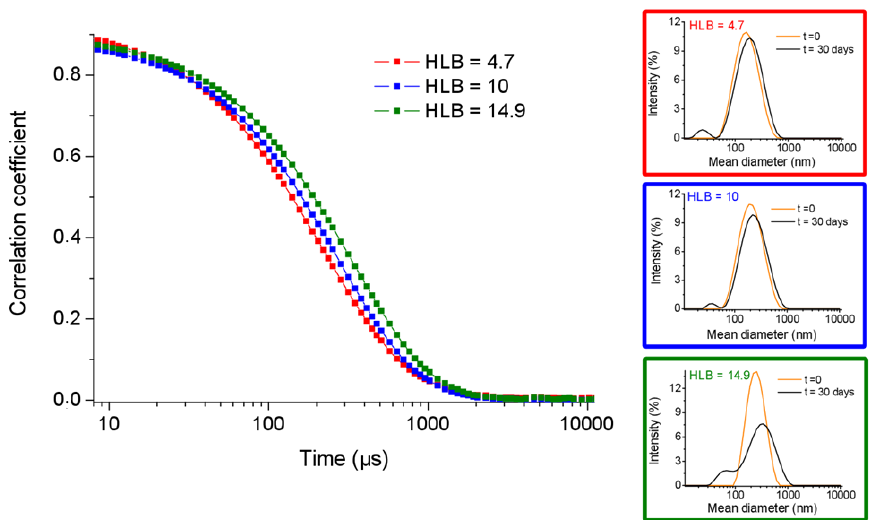
Figure 3. Intensity correlation functions for Fmoc-FF nanogels prepared according to the inverse emulsion at three di ff erent HLB values (4.7, 10, and 14.9). On the right, the dynamic light scattering (DLS) profiles for these formulations freshly prepared and after one month. Molecules 2020 , 25 , x FOR PEER REVIEW